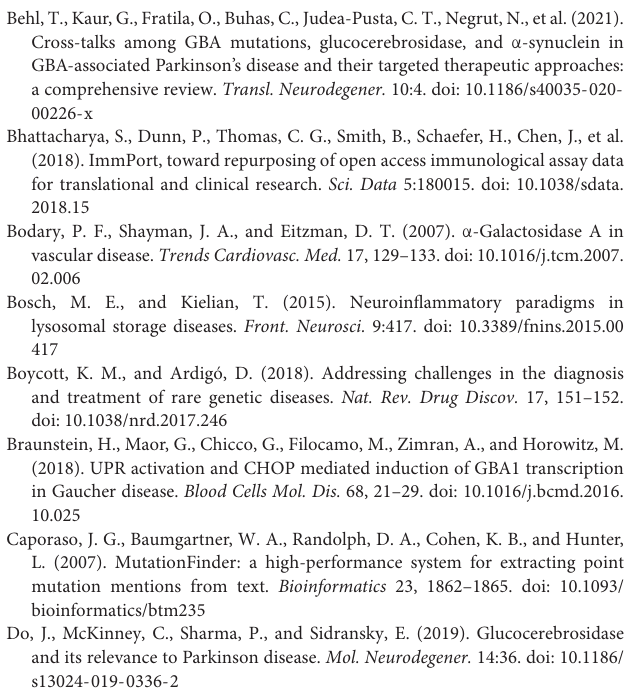
Supplementary Table 1 | Selected GD and FD transcriptomic and proteomic datasets. Supplementary Table 2 | Selected sentences from GD literature. Supplementary Table 3 | Selected sentences from FD literature. Supplementary Table 4 | Selected sentences from ASMD